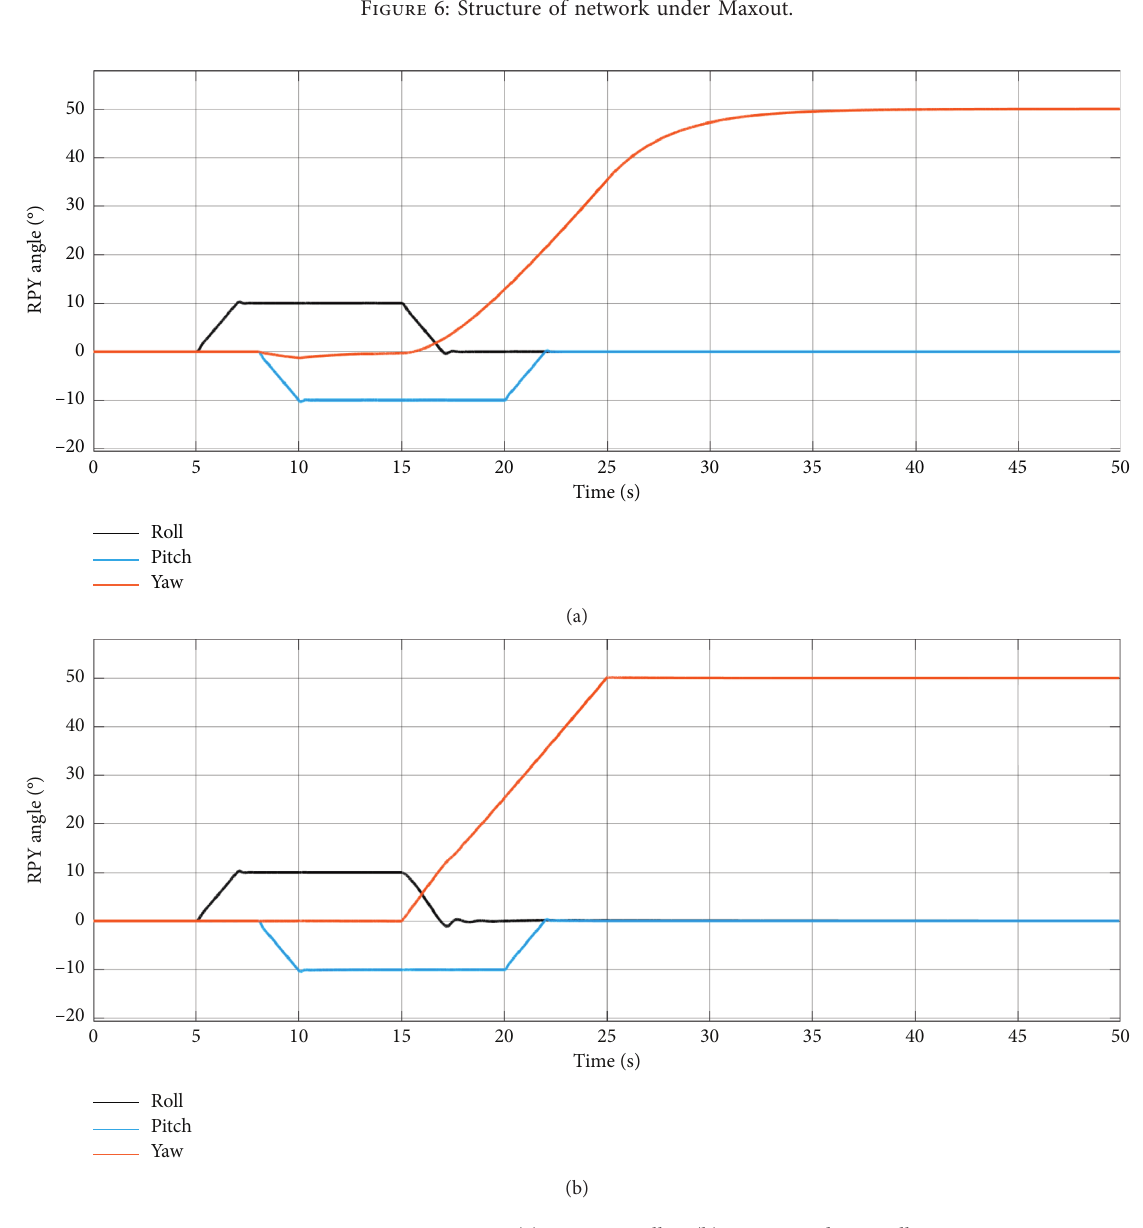
Figure 7: RPY response curve. (a) PID controller. (b) Compound